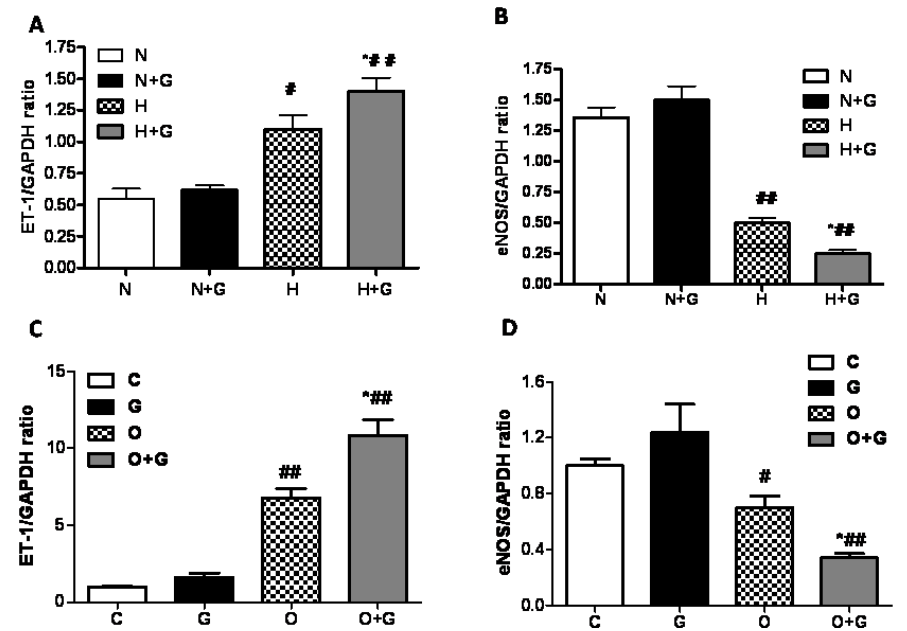
Figure 5. The effect of G-CSF on the expression of ET-1 and eNOS in thoracic aortae and endothelial cells. Analysis of ET-1 ( A ) and eNOS ( B ) mRNA expression in thoracic aortae. N: normal diet group, N + G: normal diet group treated with G-CSF, H: high-fat diet group. H + G. high-fat diet group treated with G-CSF. Results are expressed as means ± SEM. * p < 0.05, normal diet +G-CSF vs. normal diet group, or high-fat diet +G-CSF vs. high-fat diet group # p < 0.05 ## p < 0.01 high-fat diet group vs. normal diet group or high-fat diet +G-CSF vs. normal diet +G-CSF. Analysis of ET-1 ( C ) and eNOS ( D ) mRNA levels in cultured endothelial cells. C: Control group. G: G-CSF group. O: OX-LDL group. O + G: OX-LDL + G-CSF group. Results are expressed as means ± SEM. * p < 0.05, G-CSF vs. control group, or OX-LDL +G-CSF vs. OX-LDL group # p < 0.05, ## p < 0.01 OX-LDL vs. control group or OX-LDL + G-CSF vs. G-CSF group. Each experiment was repeated independently at least three